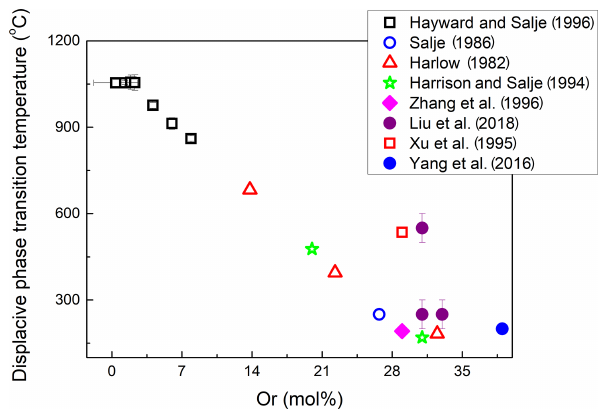
Figure 1. Relationship between displacive phase transition temper- ature in anorthoclase and Or